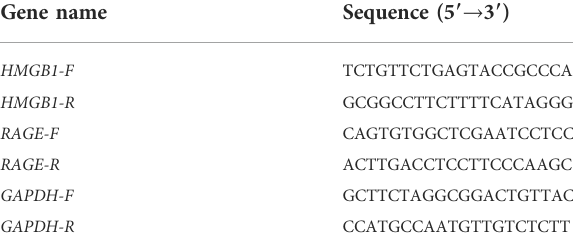
TABLE 2 Sequences of quantitative real-time PCR